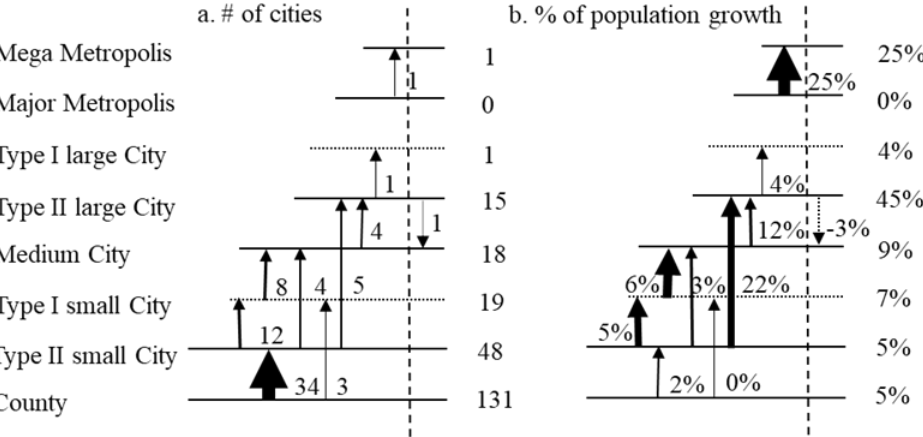
Figure 4. Number of cities and share of cities’ increment to total population growth across hierarchies in 1990–2000. Note: a indicates number of different ranking cities, b indicates the share of cities’ population growth. Numbers or proportions near the arrow present changes in the time periods. Numbers on the right of lines are values of the base period. The same applies to the figures below.